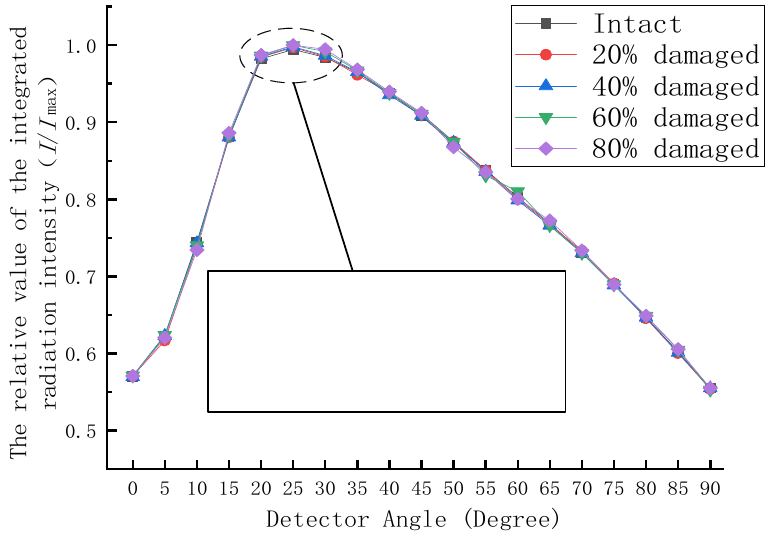
Figure 13. Radiation intensity curves of adjusting plates 1 and 4 of the 3–5 μm band with different damage degrees.